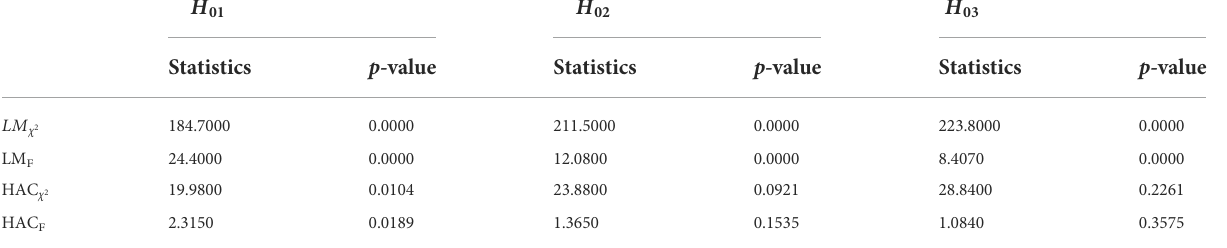
TABLE 5 Parameter constancy